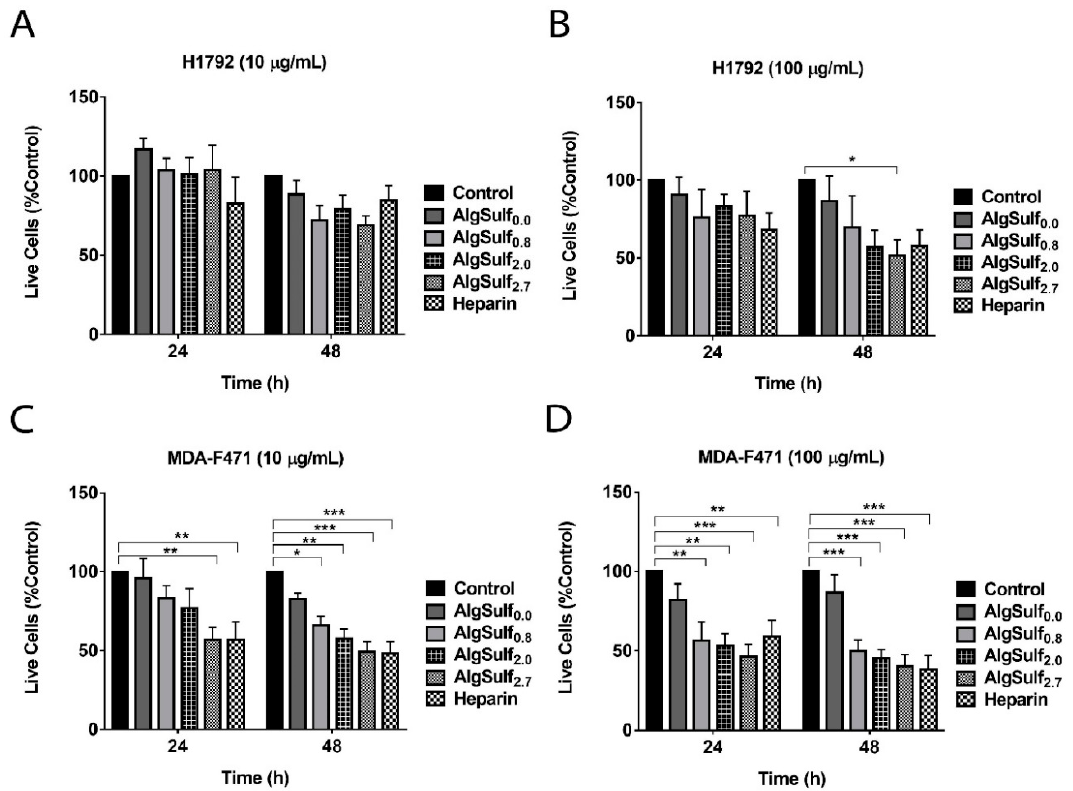
Figure 2. The effect of the DS of biomimetic sulfated GAGs on the viability of human and murine LUAD cell lines ( A ) H1792 treated with 10 µ g / mL of AlgSulf n , ( B ) H1792 treated with 100 µ g / mL of AlgSulf n , ( C ) MDA-F471 treated with 10 µ g / mL of AlgSulf n , and ( D ) MDA-F471 treated with 100 µ g / mL of AlgSulf n assessed using a trypan blue exclusion assay. For each graph, heparin was added at the same concentration of the polysaccharides as a positive control, and untreated cells (media only) were used as a negative control. Results are expressed as the percentage of the treated group compared to the control after 24 h and 48 h of culture. Data represent the average of five independent experiments and are reported as mean ± SEM (* p < 0.05; ** p < 0.01; *** p < 0.001) using two-way ANOVA followed by Bonferroni’s multiple comparison test.